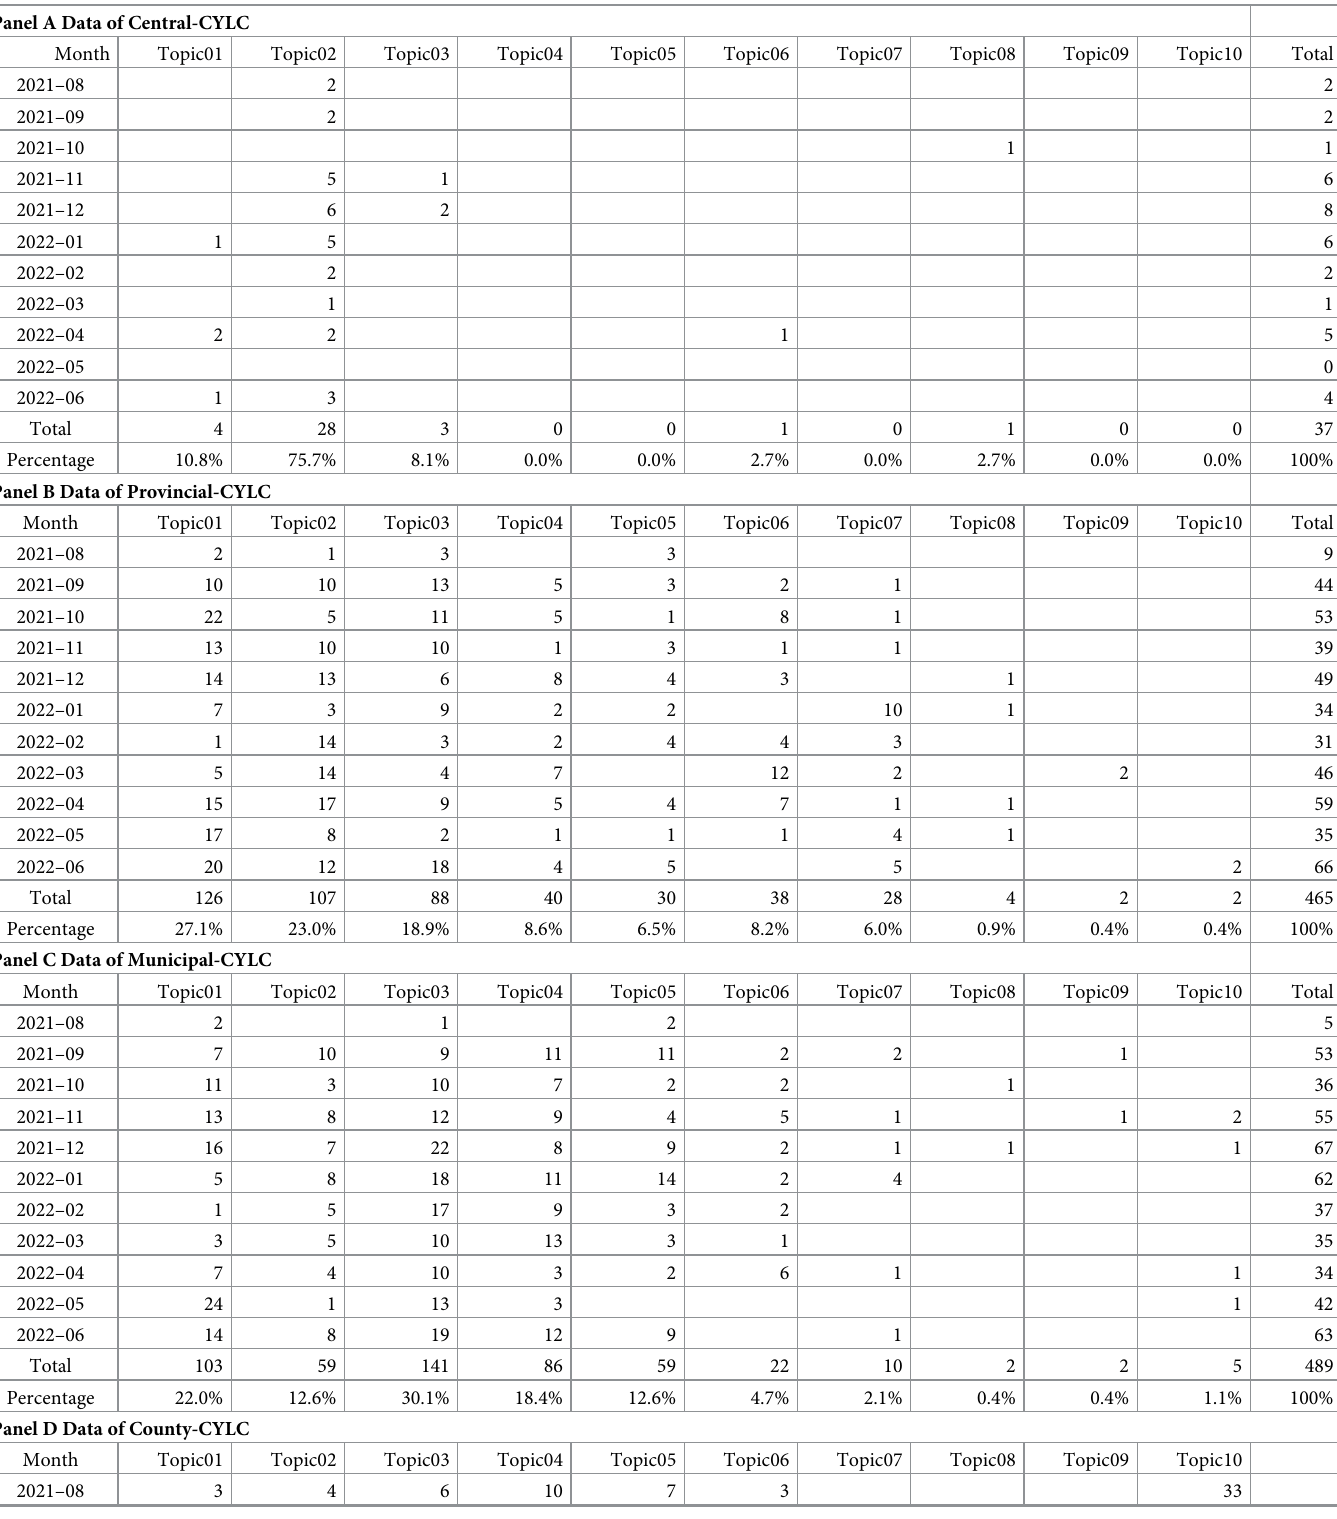
Table 7. News topic distribution of each level of league organization. Panel A Data of